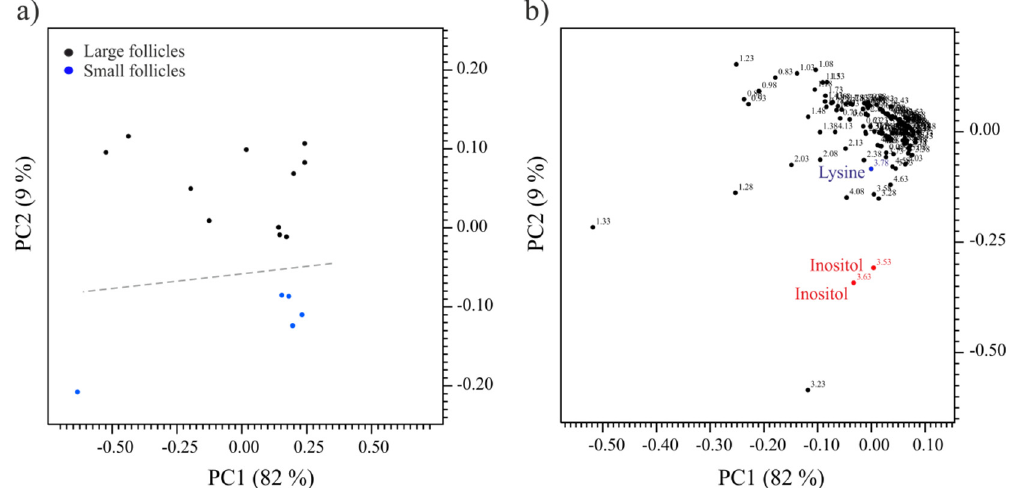
Figure 4. ( a ) PCA scores plot (PC1-PC2) from 1H NMR spectral data of follicular fluid samples of prepubertal goats. Blue dots correspond to samples with small follicles (n = 5) and black dots to samples with large follicles (n = 11). ( b ) PCA heat map loadings plot (PC1-PC2) with discriminant variables assigned.